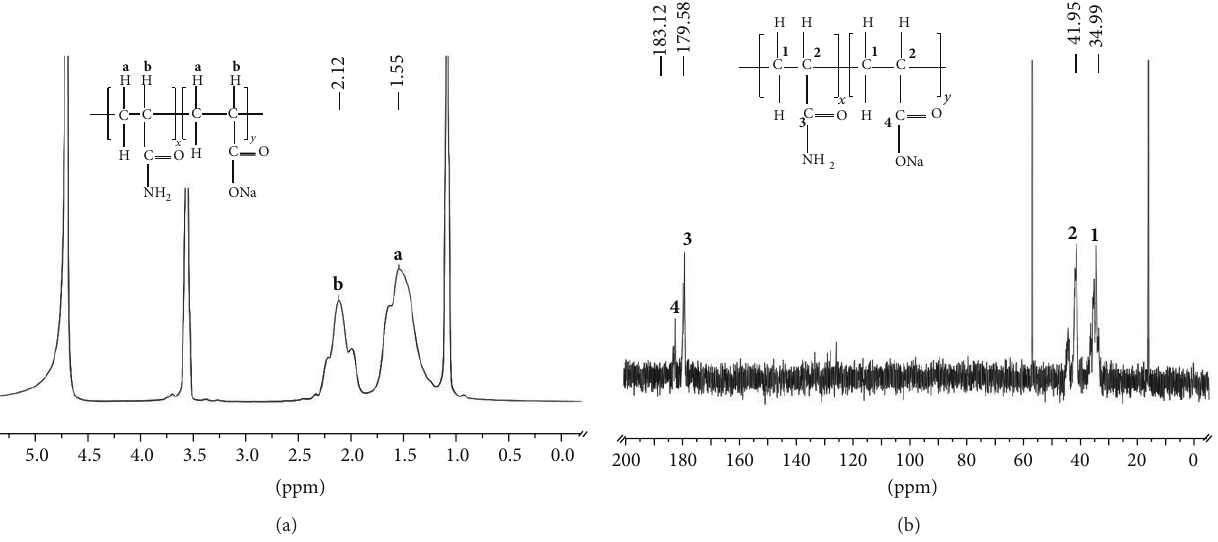
Figure 5: (a) 1 H NMR spectrum of HPAM in D 2 O; (b) 13 C NMR spectrum of HPAM in D 2 O.